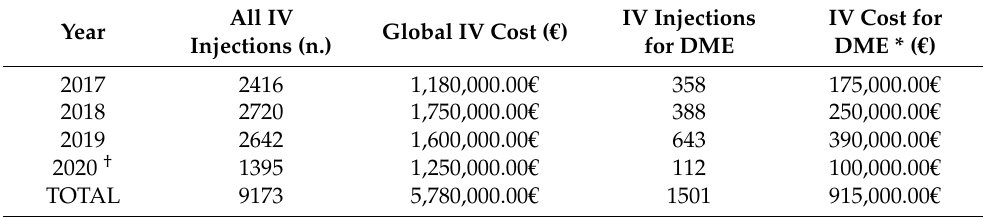
Table 2. Annual number and cost of intravitreal (IV) injections in the period January 2017–June 2020. All IV Year Injections